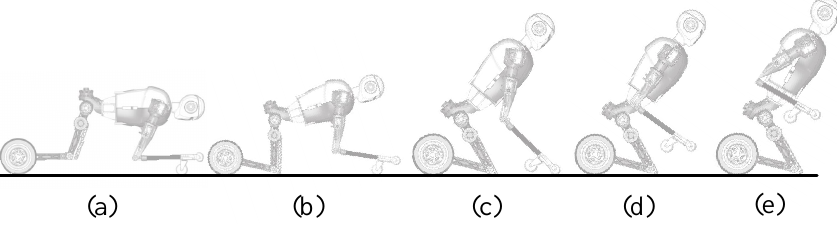
Figure 10. The transition process from crawling to kneeling ( a – e ). From Kneeling to Standing: Based on the simplified underactuated inverted pendulum model and humanoid motion, we divide the transition from kneeling to standing into two